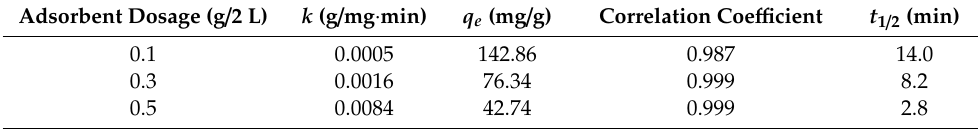
Figure 2. Effect of adsorbent CM-AC-700 dosage on methylene blue (MB) adsorption (initial MB concentrations = 10 mg/L, agitation speed ＝ 200 rpm, and temperature ＝ 25 °C); symbols: measurement data, full lines: calculated from the fitted values (Table 2).